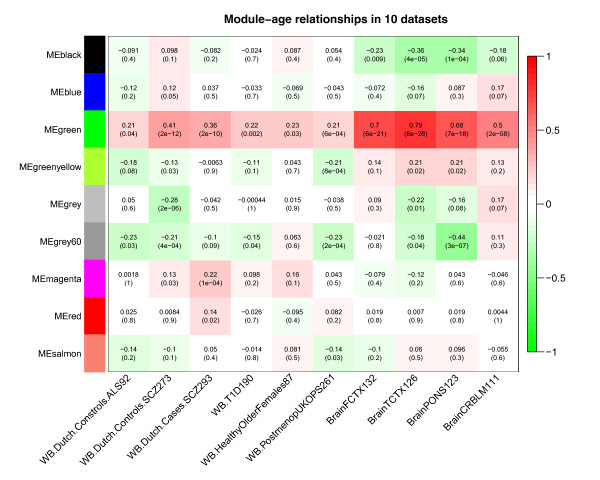
Correlating consensus modules with age in the ten reference data sets. Each row corresponds to a consensus co-methylation module (defined in Figure 3). More precisely, each row corresponds to the first principal component of each module (referred to as eigengene). The columns correspond to the age variable in each of the ten reference data sets. Each cell reports the correlation coefficient between the eigengene and age (top) and the corresponding P-value (bottom). Cells in the table are color coded using correlation values according to color scale on the right - that is, strong positive correlations are denoted by strong red color, and strong negative correlations by strong green color.